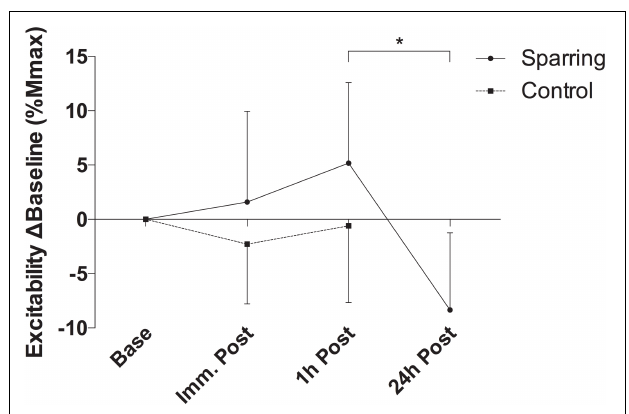
FIGURE 2 | Difference of corticospinal excitability for sparring and control groups, relative to baseline. Excitability appears slightly increased immediately